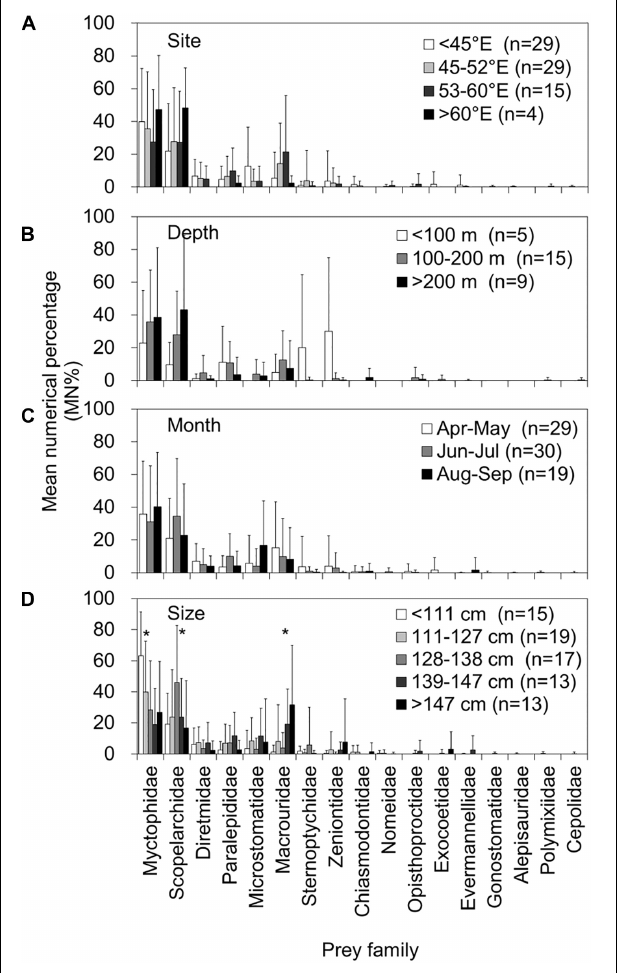
FIGURE 6 | Mean numerical percentage (MN%) and standard deviations (vertical lines) of the prey item by prey family in 78 otolith remain-containing stomachs of bigeye tuna ( Thunnus obesus ) by (A) capture site, (B) depth, (C) month, and (D) fish size. The asterisks indicate levels of significance: